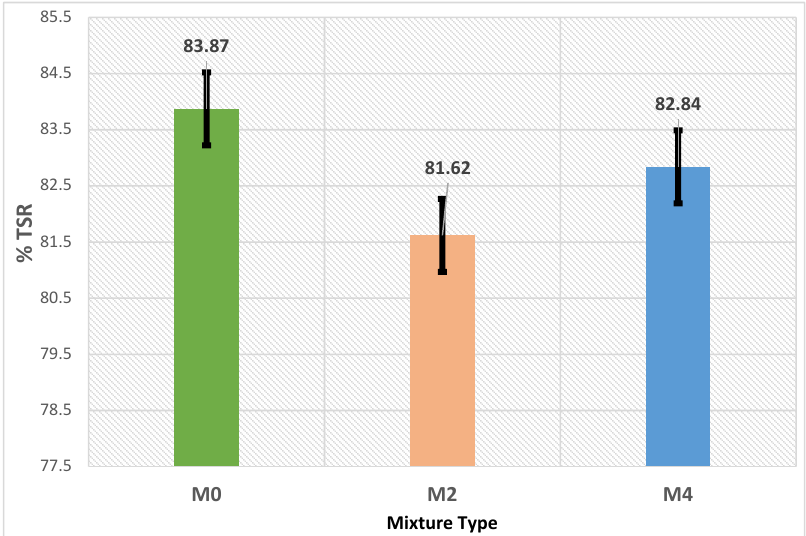
Figure 8. Tensile Strength Ratio (TSR) results.